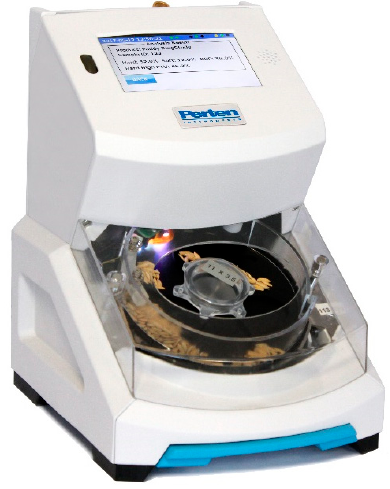
Figure 1. The PaddyCheck Instrument.